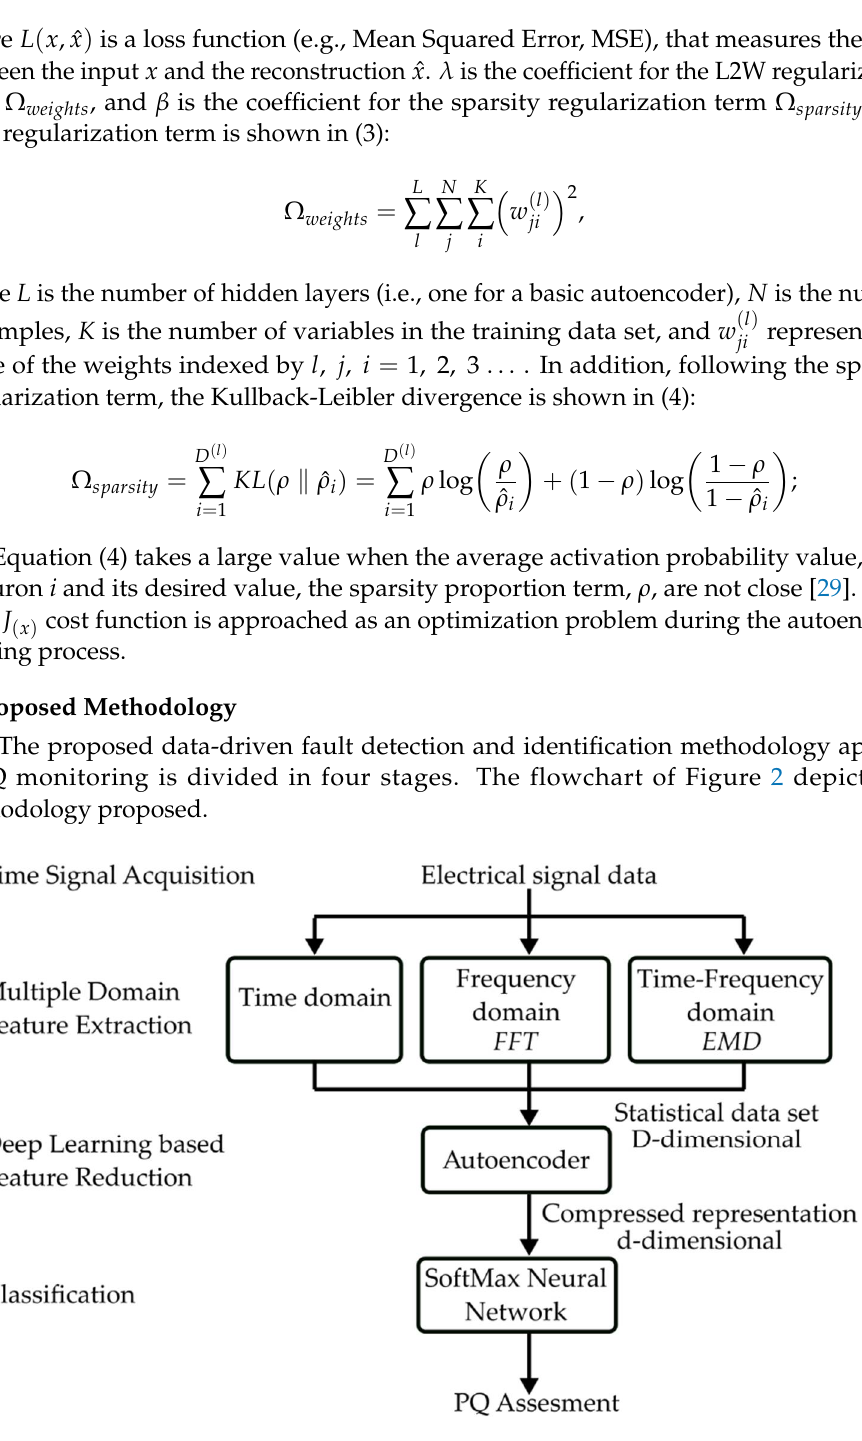
Figure 2. Flowchart of the proposed deep learning-based methodology applied to PQD monitoring.